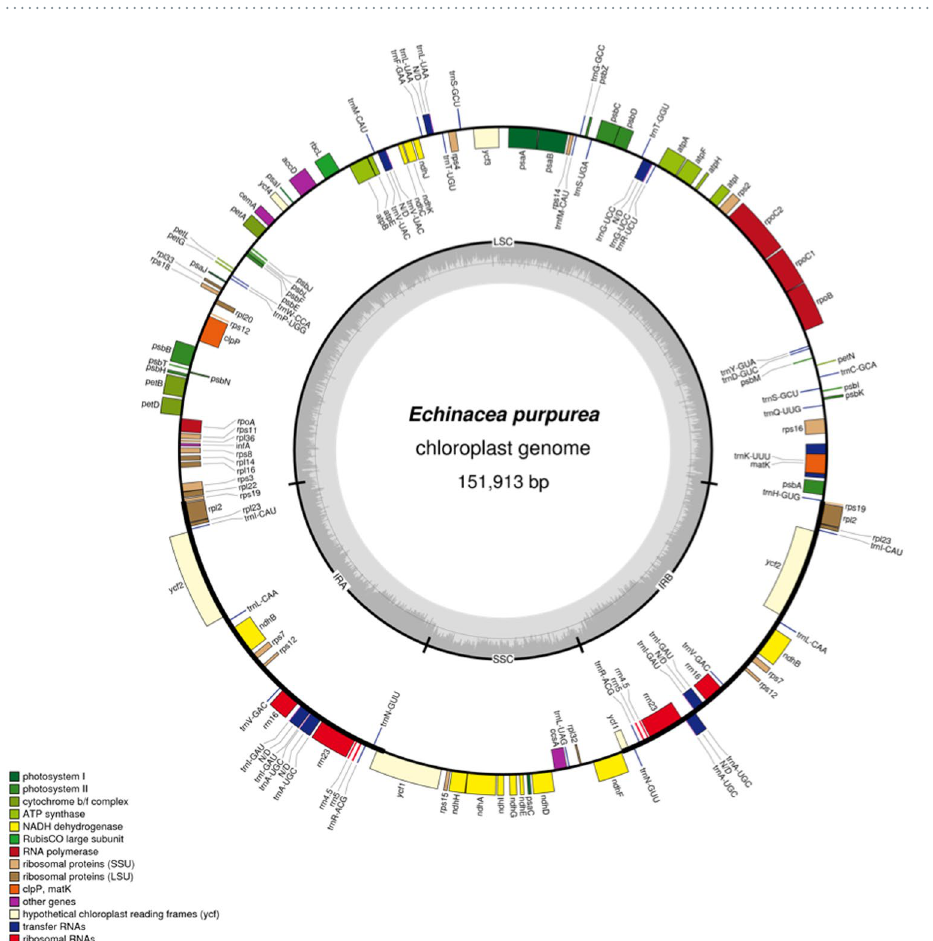
Figure 1. Gene map of the Echinacea purpurea chloroplast genome. Genes shown outside the circle are transcribed clockwise and those inside are transcribed counterclockwise. Gene belonging to different functional groups are color-coded as indicated by icons on the lower left corner. Dashed area in the inner circle indicates the GC content of the chloroplast genome. LSC, SSC and IR means large single copy, small single copy and inverted repeat,